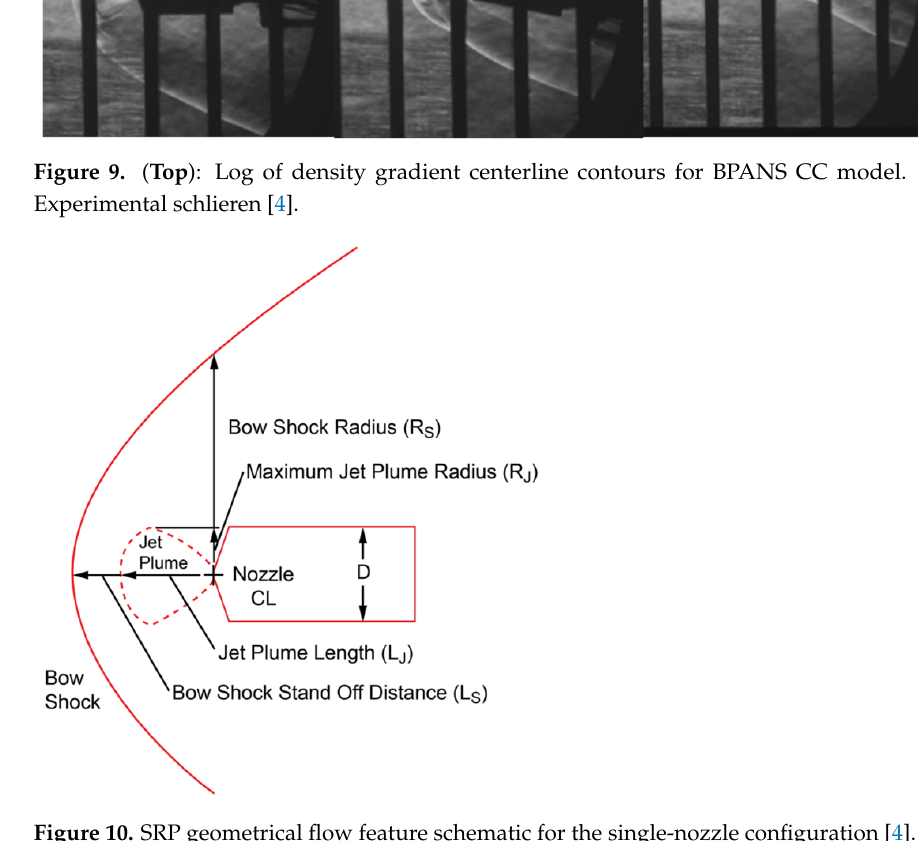
Figure 10. SRP geometrical flow feature schematic for the single-nozzle configuration [4].